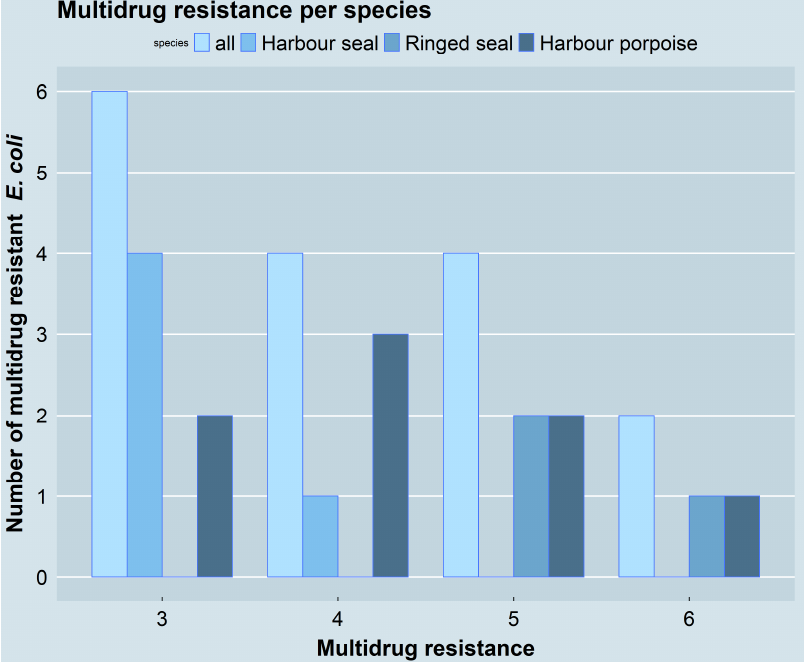
Figure 5. Multidrug resistance. The graphic depicts the number of multidrug resistant isolates with resistance against 3, 4, 5, and 6 antimicrobial classes for all species as well as separated for the individual species. The figure was created using RStudio version 1.4.1103 (R version 4.1.2) with the package ggplot2.